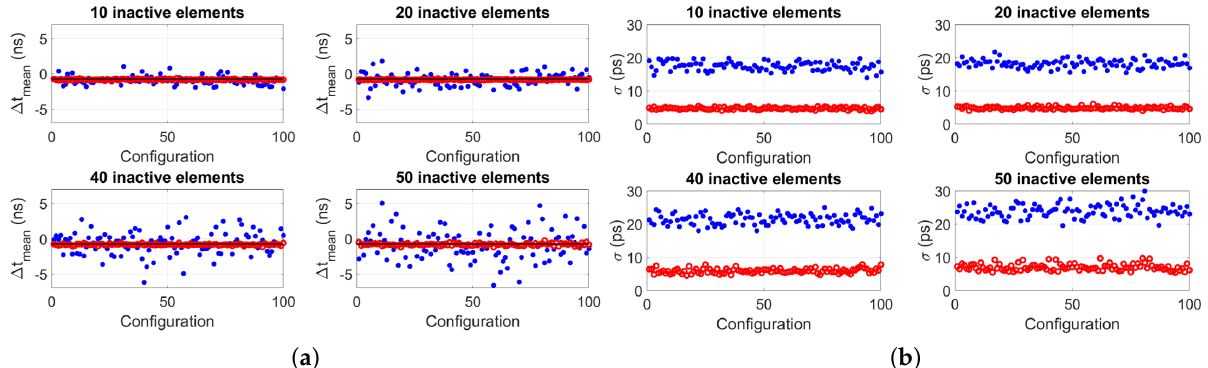
Figure 10. Measurement results of ( a ) mean transit time difference for 100 random configurations for the cases of a total of 10, 20, 40 and 50 inactive array elements situated at random locations along the aperture of 96 − elements arrays. Per configuration, a data point represents the mean of 50 transit time difference measurements carried out. The blue dots represent the values obtained without implementing the proposed algorithm (i.e., after just beam-forming, obtaining and averaged signal per array and cross-correlating them to obtain the transit time difference), and the red circles represent the values obtained after implementing the proposed algorithm. The horizontal black line represents the value obtained without inactive elements, i.e., ∆ t mean = − 0.76ns. ( b ) Standard deviation of the ∆ t mean value of each configuration reported in ( a ). Each data point represents the standard deviation of 50 transit time difference measurements carried out per configuration.